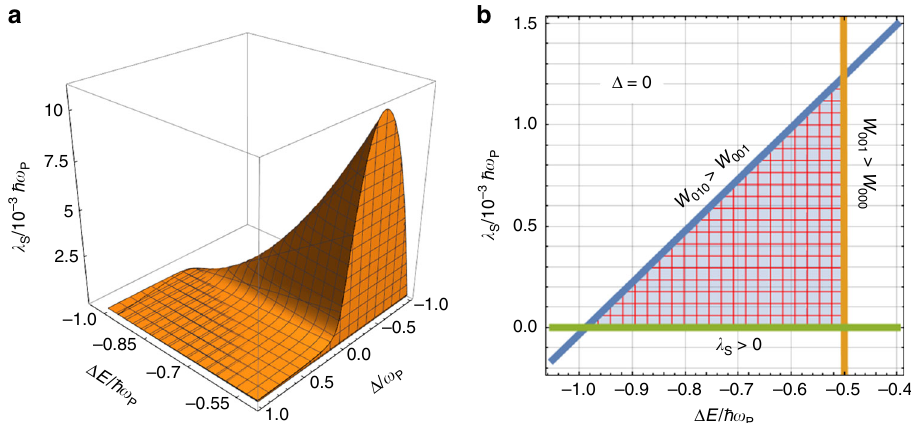
Fig. 2 Electron transfer parameters for catalytic behavior. The lower polariton (LP) channel dominates the kinetics over the many dark (D) channels for these values of Δ E (the energy difference between product P and reactant R), λ cavity and the high-frequency mode of the product). In a we explore the three variables, whereas in b we show the cross-section under the resonant condition. For these calculations, the reactant and product modes have equal high-frequencies ω splitting is _ Ω ¼ 5 ´ 10 (cid:1) 2 _ ω P